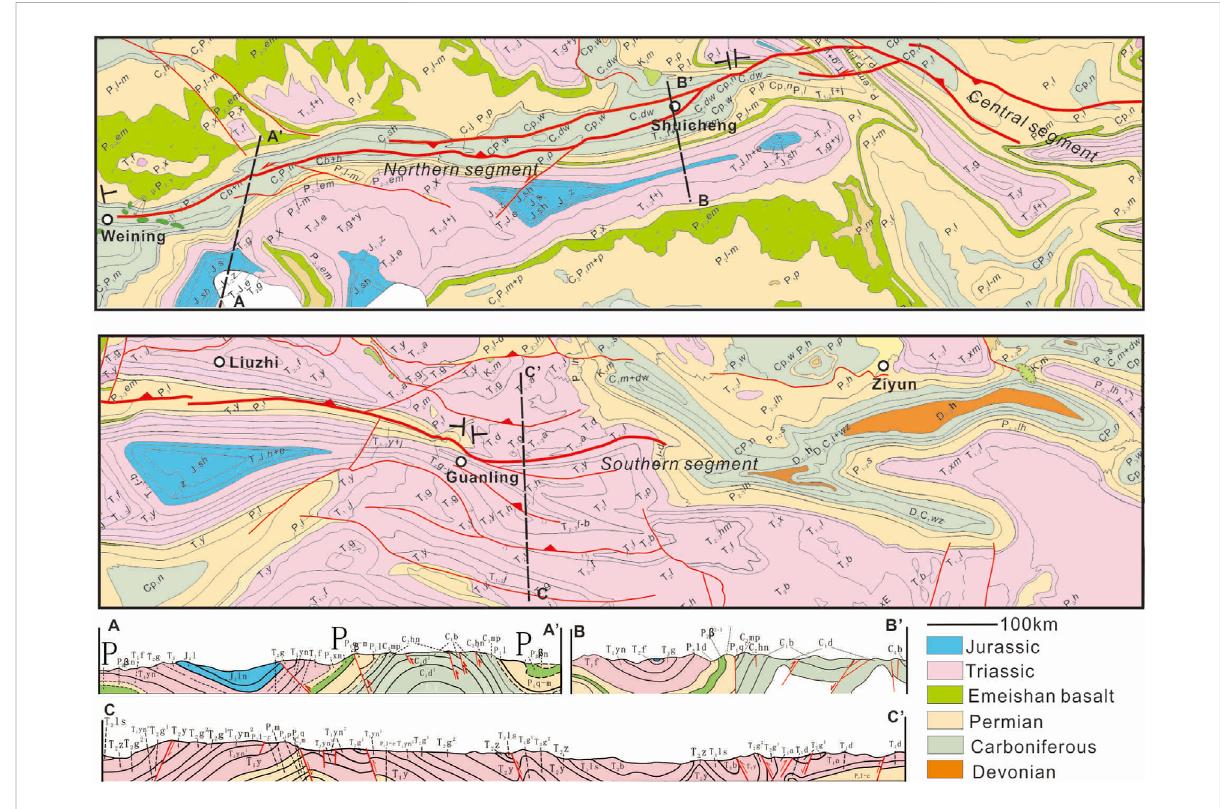
Geological map and cross-sections of the Ziyun-Luodian fault and adjacent